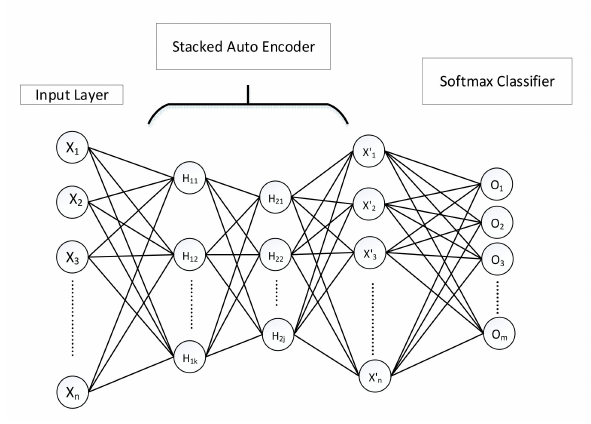
Figure 5. Stacked auto-encoders